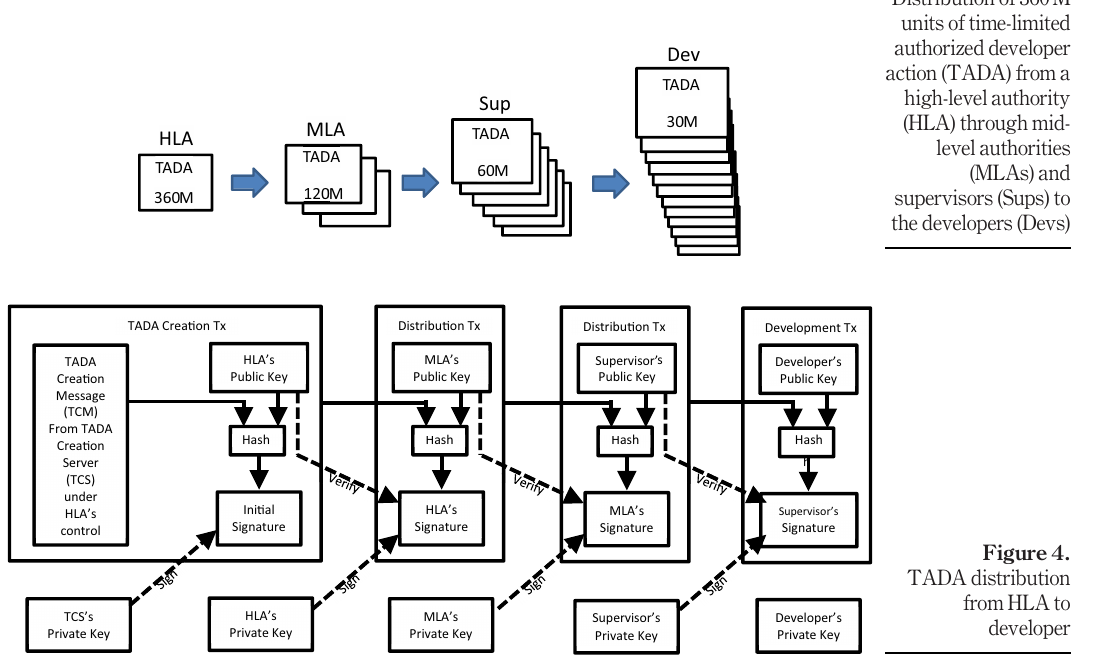
Figure 3. Distribution of 360M units of time-limited